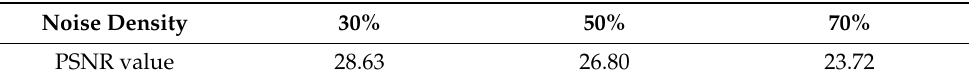
Table 11. The average value of PSNR for setting parameters using the PSRNR formula.